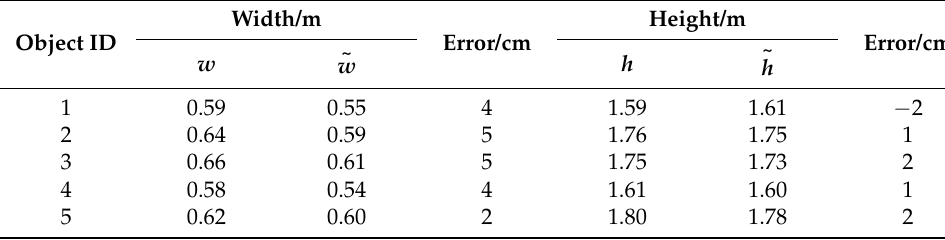
Table 7. Errors in the geometry information of the moving